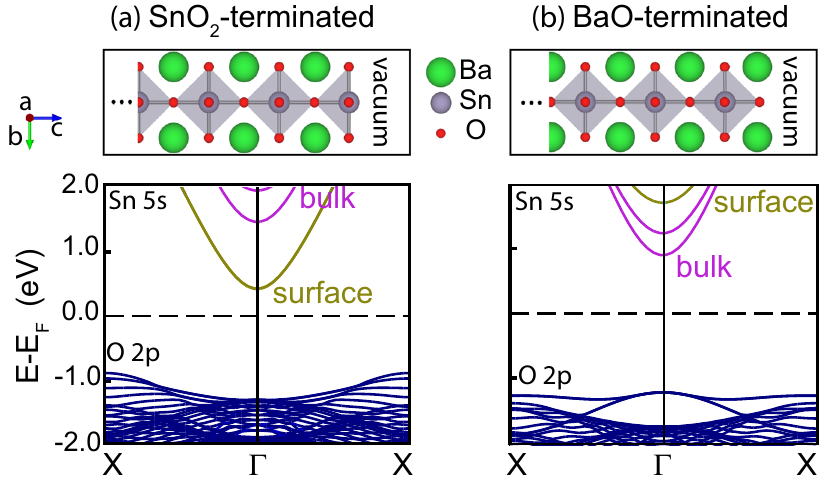
Fig. 4 Comparison of the calculated electronic structure of BaSnO 3 slab with different terminations. a Optimized SnO 2 -terminated slab structure and corresponding orbital-resolved density functional theory band structure along X- Γ -X. The valence band is dominated by O 2p states, while the conduction band is dominated by Sn 5s states. Bands originating from the surface Sn atoms are highlighted in gold, while bands originating from the Sn atoms in the central layers of the slab, which represent the bulk, are highlighted in pink. b Equivalent data for a BaO-terminated slab. The crystal structures were generated with the VESTA software 41 , and the band structures were plotted with PyProcar 42